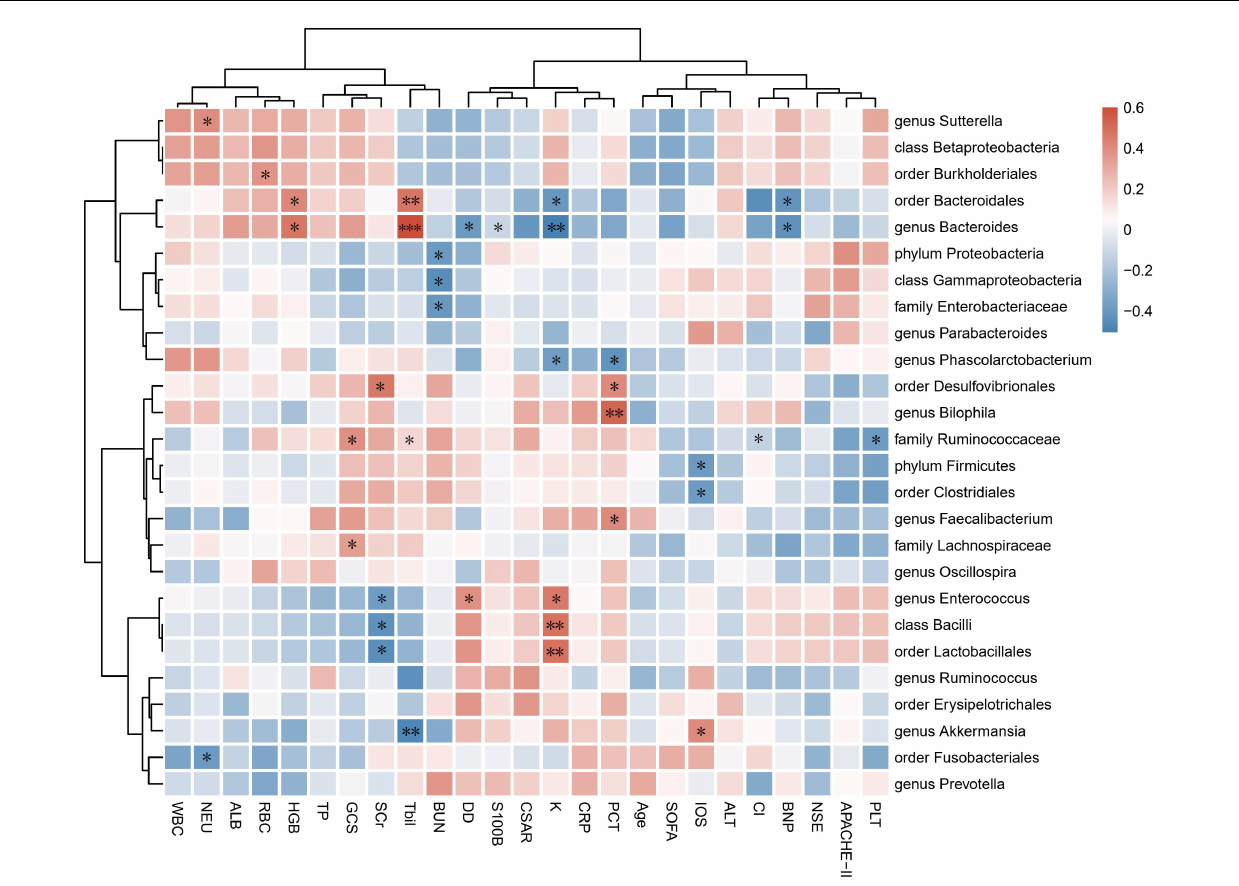
( r = − 0.387, p = 0.042 and r = − 0.383, p = 0.044,